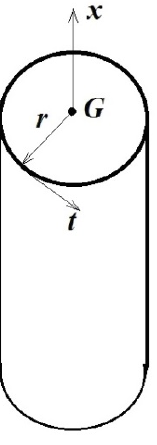
Figure 2. Bar with circular section.